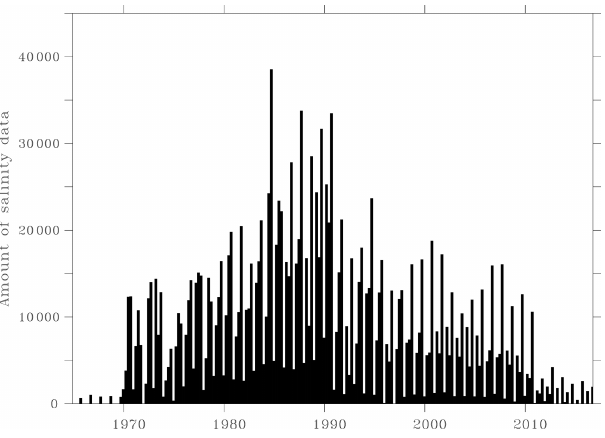
Figure 3. Availability of salinity data in the Barents Sea as a func- tion of time